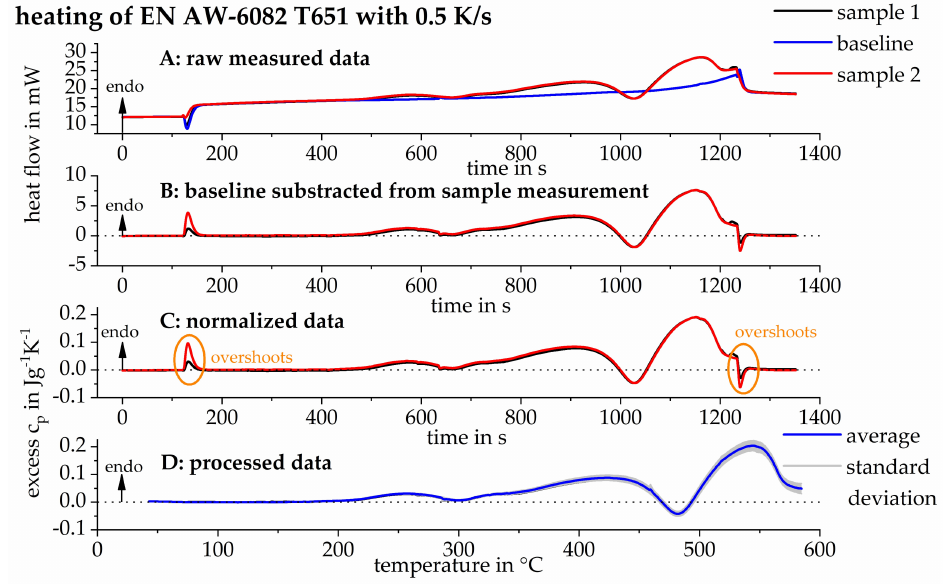
Figure 1. Evaluation procedure of the heating experiments. ( A ) Raw data measurements; ( B ) subtraction of baseline measurements from the sample measurements; ( C ) normalization of the data; ( D ) processed